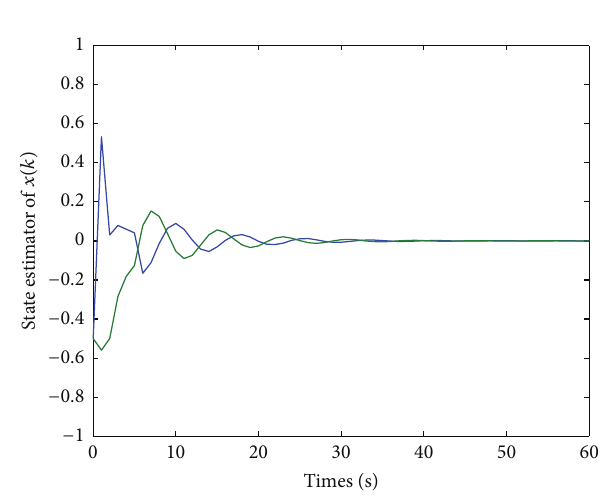
Figure 1: The trajectories of 𝑥(𝑘) with 𝐽 = 0 .